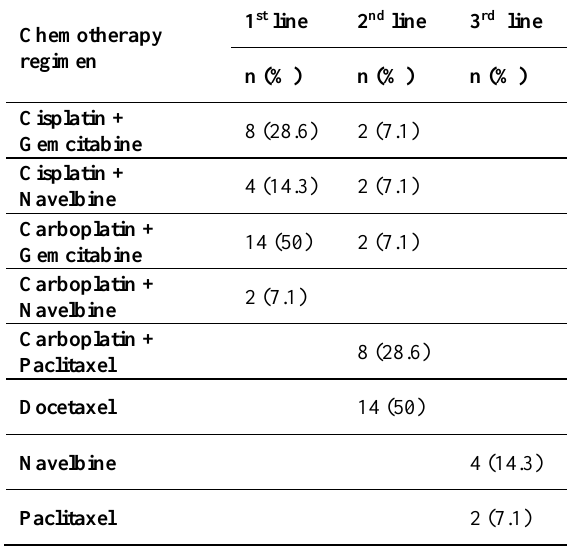
Table 2: Systemic chemotherapy in 28 NSCLC patients